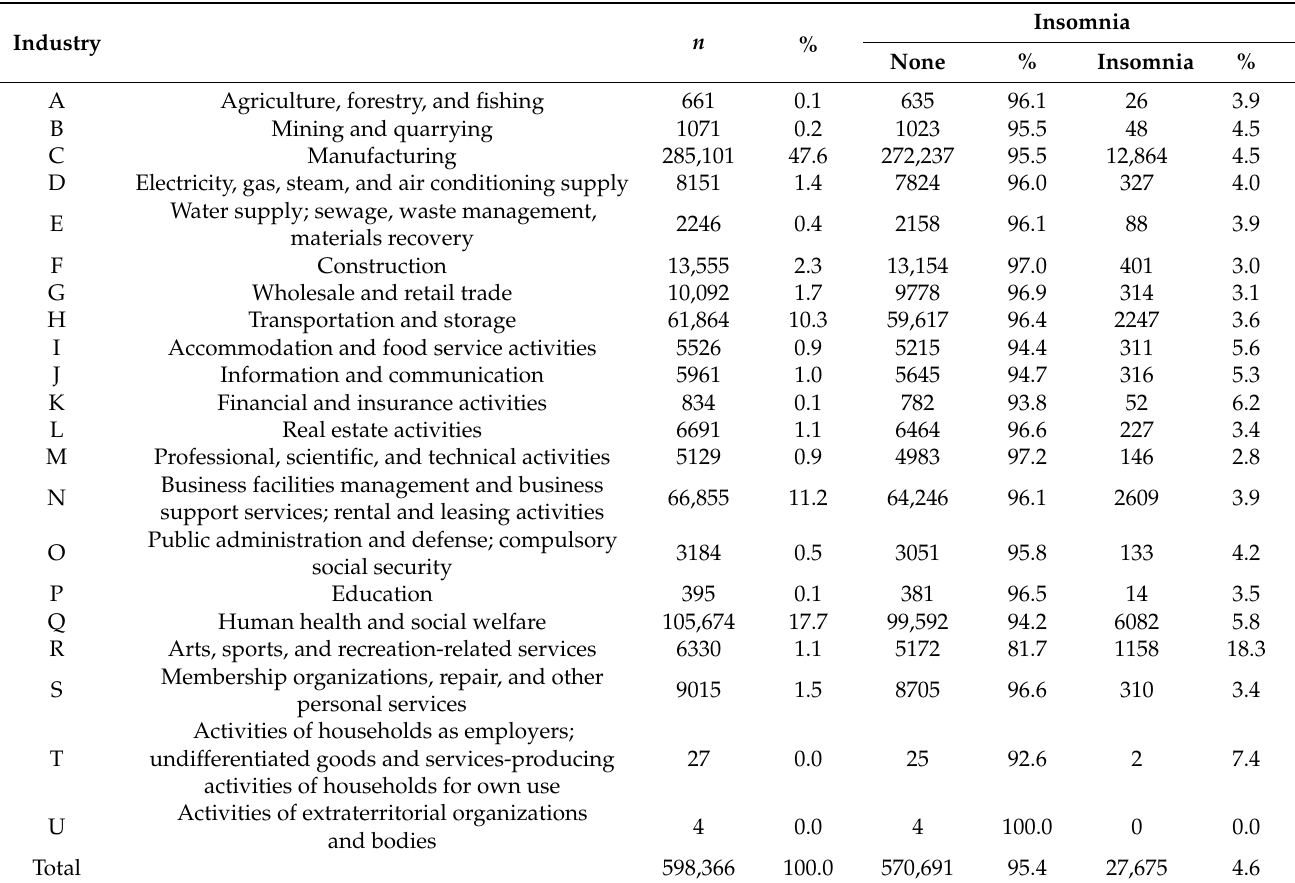
Table 1. Frequency distribution of night-shift Workers’ Specific Health Examination in 2015 according to type of industry *.